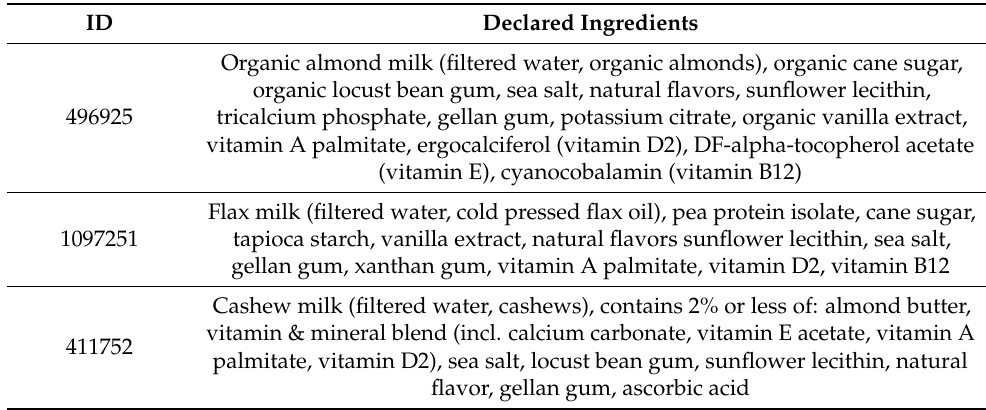
Table 1. Selected ingredient lists for PB milk alternatives and PB waters.